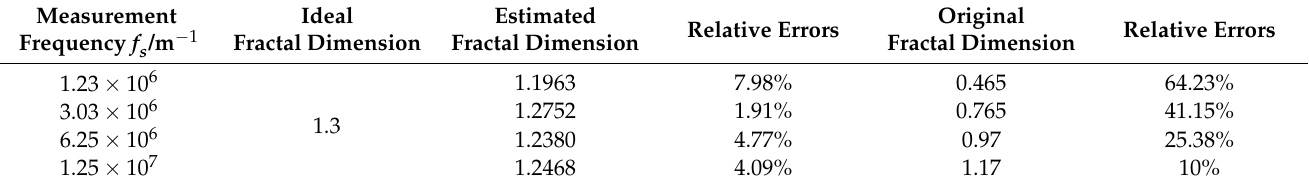
Table 9. Fractal dimension D obtained by different methods and their relative errors between the ideal D .